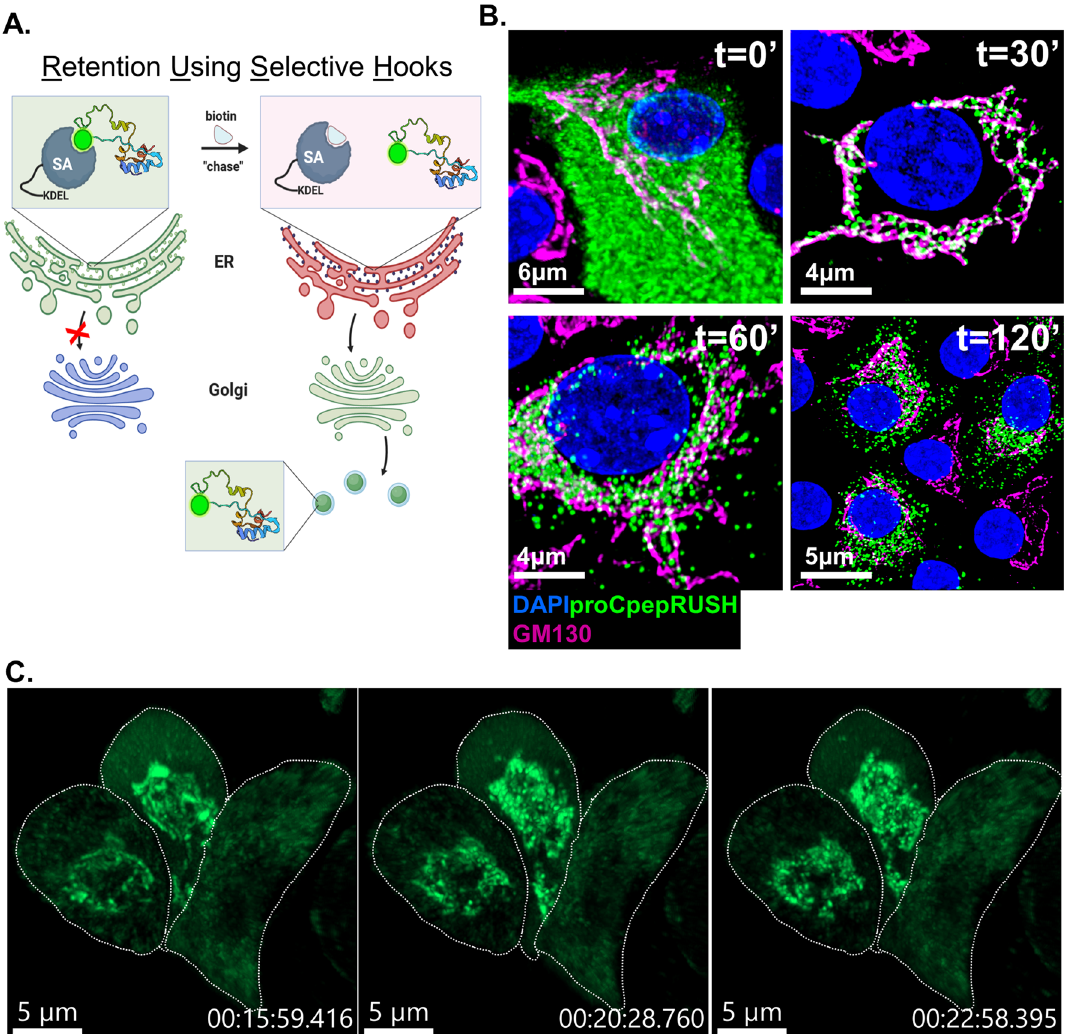
Figure 1. Proinsulin trafficking using RUSH in primary mouse β-cells. ( A ) Schematic of proCpepRUSH trafficking was created using biorender.com. ( B ) Mouse islets (C57BL6/J) treated with AdRIP-proCpepRUSH were examined 48 h post-infection. Biotin addition (200 μM) was used to initiate proCpepRUSH (green) trafficking. Islet cells were fixed at the indicated times post-biotin addition and immunostained for GM130 (magenta) and counterstained with DAPI (blue). ( C ) Specific time points from time-lapse imaging (Movie S1) of proCpepRUSH trafficking are shown with cell RUSH) are present in the same β-cell and that SA-KDEL is in molar excess to proCpepRUSH, which ensures high fidelity of the trafficking system. Using the RUSH system (SA-KDEL and proCpepRUSH), synchronous release of proinsulin was examined in primary mouse islets. Prior to biotin administration, proCpepRUSH was present throughout the lacy network of the cell body (Fig. 1B, t = 0) and precisely mirrors SA-KDEL immunostaining (Fig. S1A). This staining pattern is consistent with ER localization and likely reflects the tight association of proCpepRUSH-containing SBP and the ER-localized SA-KDEL. Following biotin addition, proCpepRUSH was observed in the Golgi region (indicated by GM130, magenta) within 30 min, and remained proximal to the Golgi for an additional 30 min (t = 60 min) (Fig. 1B, Movie S1). At 120 min post-biotin addition, numerous proCpepRUSH puncta were evident throughout the cell body distinct from the Golgi (Fig. 1B) and the ER (Fig. S1B) suggesting that proCpepRUSH-containing vesicles had been released from the Golgi and entered the pool of insulin storage granules (Movie S1). Upon further examination of Golgi transit, we noted the appearance of proinsulin in the Golgi structure was initially diffuse (Fig. 1C, t = 15 min and Movie S1), but transitioned to discrete regions of high-density staining (Fig. 1B, t = 30 min and Fig. 1C, t = 20 and 23 min). These data are consistent with studies demonstrating that proinsulin condenses in the Golgi prior to delivery into the budding secretory granule 14,20 . Collectively, our timeline for proCpepRUSH trafficking from the ER to the granule is consistent with the known kinetics of proinsulin con- version to mature insulin 5,33 .